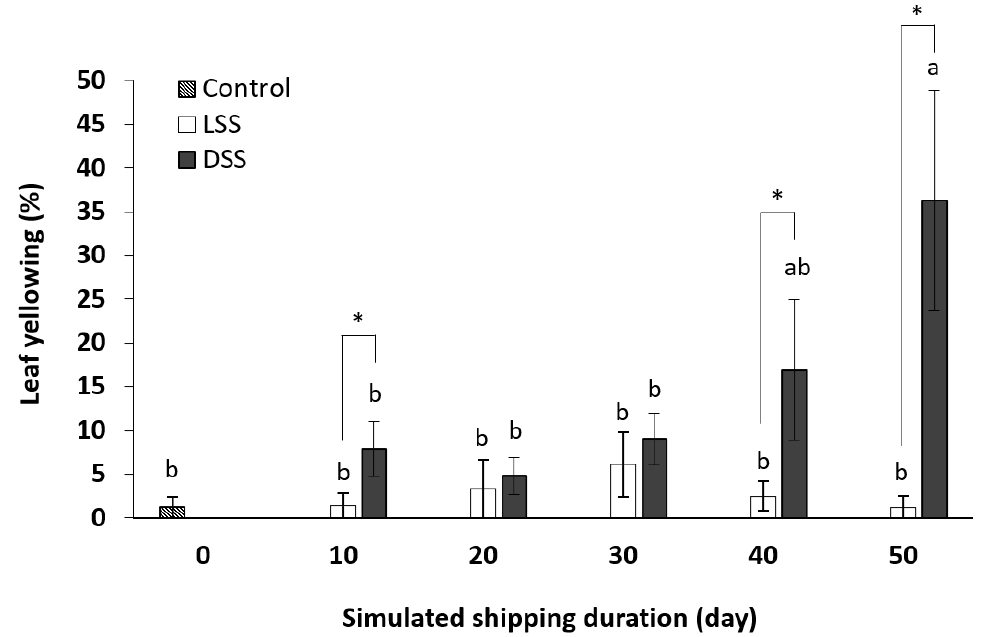
Figure 3. Leaf-yellowing rate in Phalaenopsis Sogo Yukidian ‘V3’ for 10 days after the end of each simulated shipping treatment with different duration. Within-graph means followed by the same letter are not significantly different according to Duncan’s multiple range test at p ≤ 0.05. * p ≤ 0.05.